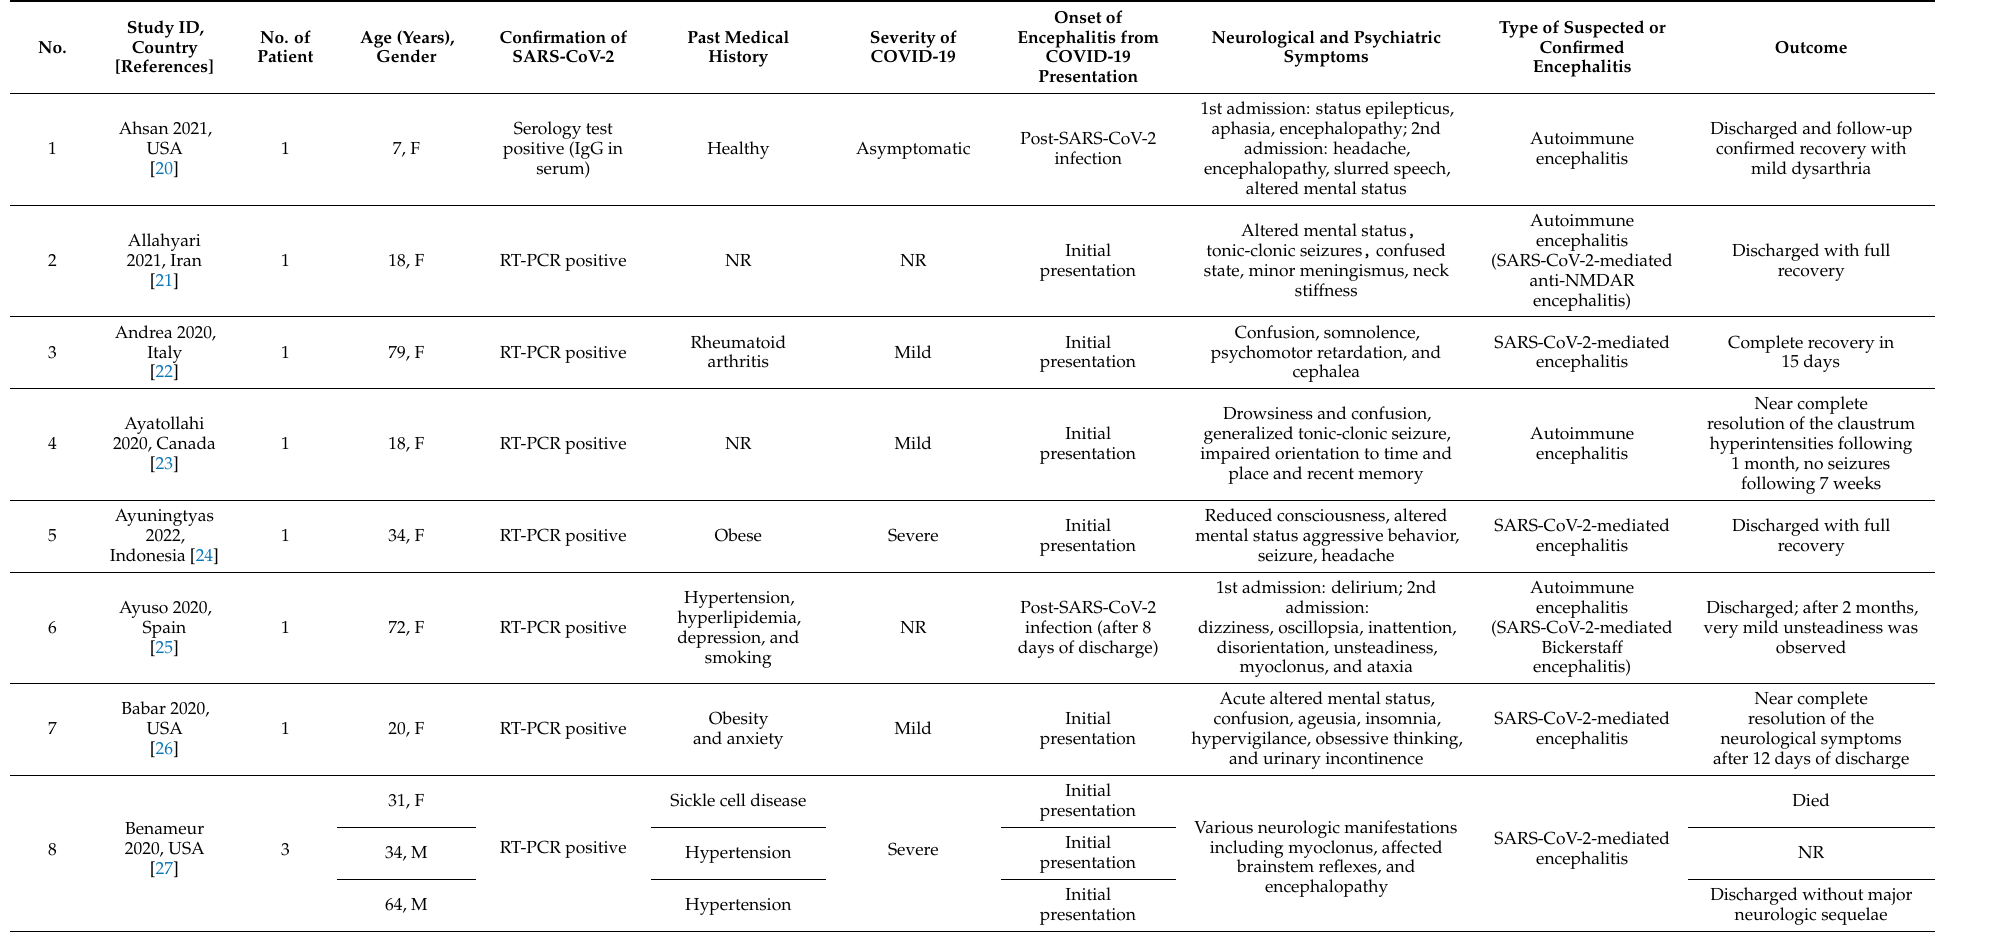
Table 1. Major characteristics of the included